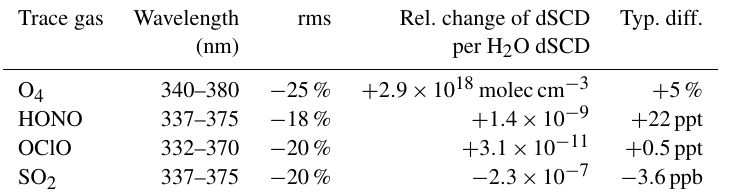
Table 5. Impact on spectral retrievals estimated from DOAS evaluations with and without accounting for the water vapour absorption from POKAZATEL for the M91 MAX-DOAS data set (at a spectral resolution of 0.45nm or 34cm at 363nm/27548cm). The typical difference was estimated for a water vapour dSCD of 4 × 10 23 moleccm − 2 along a 10km long light path.